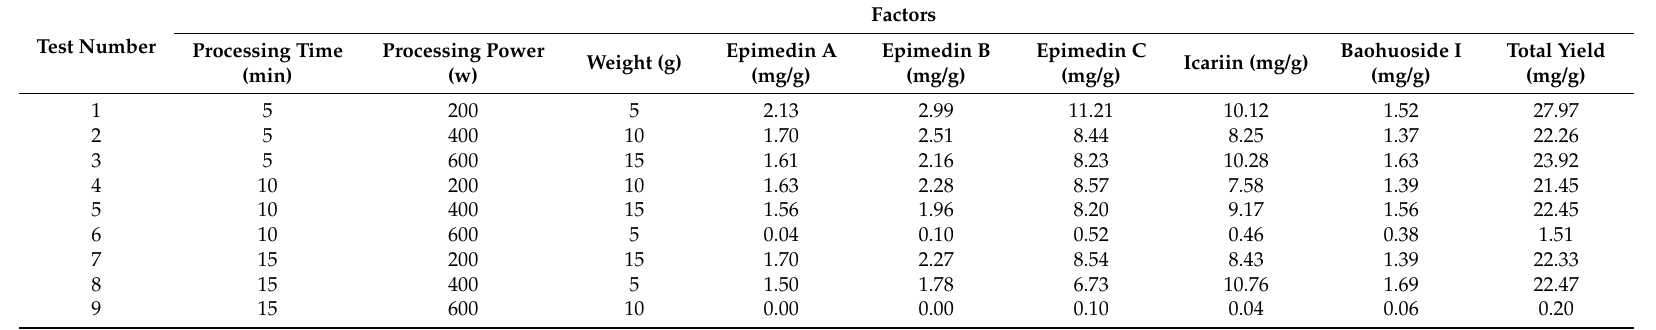
Table 2. Orthogonal array design matrix L9 (3) 4 and experimental results ( n =